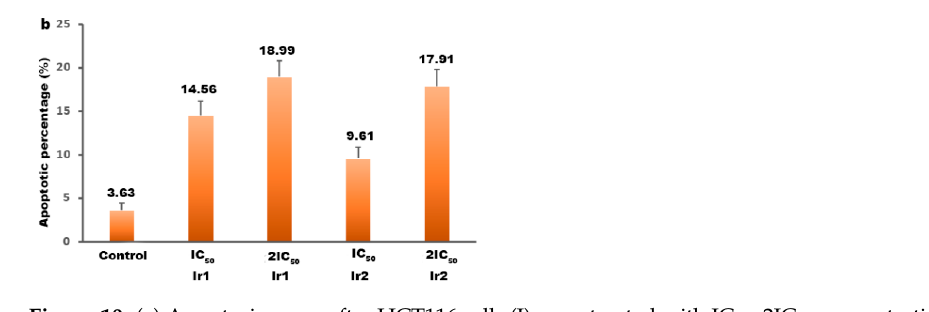
Figure 10. ( a ) Apoptosis assay after HCT116 cells (I) were treated with IC 50 , 2IC 50 concentration of the complexes Ir1 (II, III) and Ir2 (IV, V) for 24 h. ( b ) The apoptotic percentage of early and late apoptosis. Q1, Q2, Q3 and Q4 stand for necrotic cell, late apoptosis, early apoptosis and living cell,